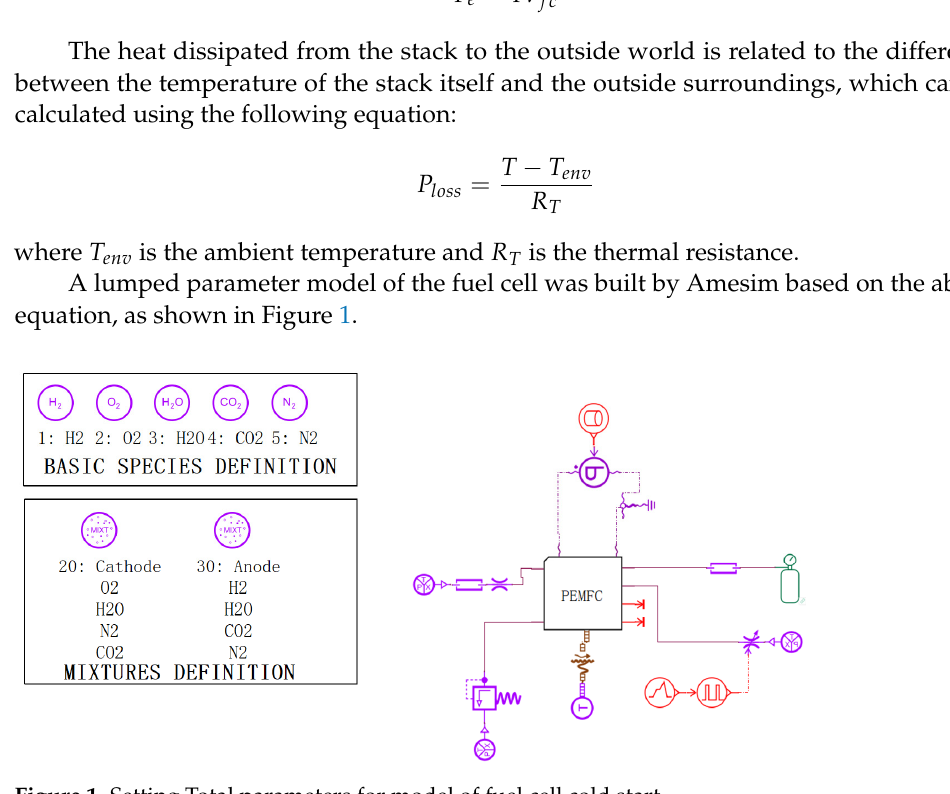
Figure 1. Setting Total parameters for model of fuel cell cold